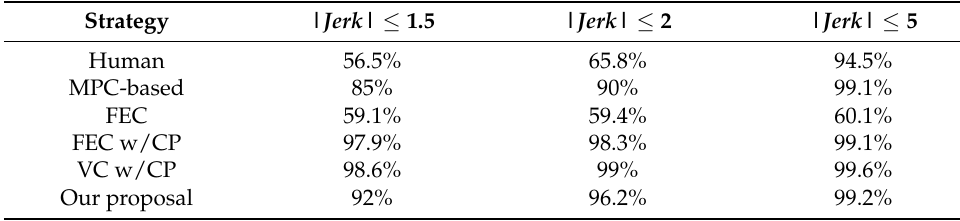
Figure 15. Comparison of jerk frequency distribution for different strategies. Table 5. Ratio of comfort for different